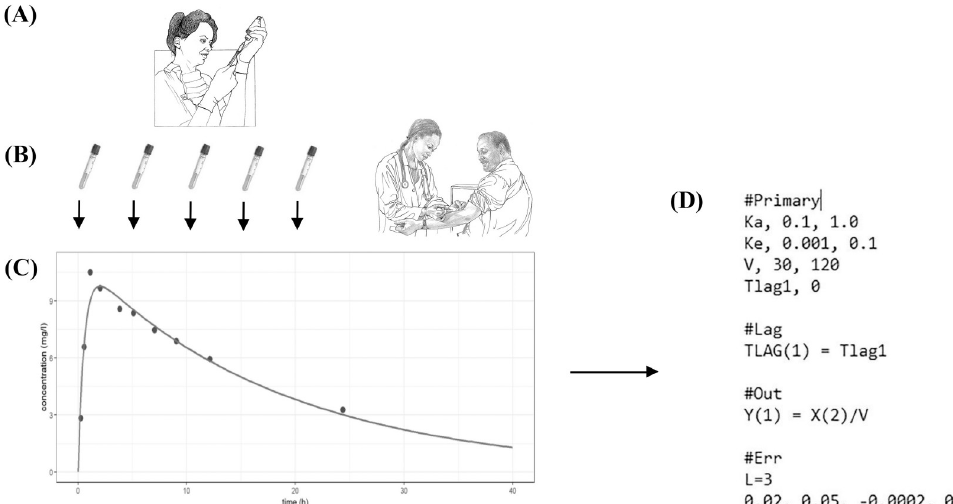
Fig 1. An overview of how therapeutic drug monitoring (TDM) results can be integrated into clinical population and individual pharmacokinetic models on which individualized drug therapy is based. After the drug is administered (A), blood is drawn at specific times (B) and submitted for analysis to obtain time-concentration data with the aim of determining the subject’s individual pharmacokinetic parameters. This can be done using, for instance, either parametric or nonparametric Bayesian analysis (C). An illustrative input pharmacokinetic model file of Pmetrics ™ , a nonparametric population modeling software suite [12], is shown (D). The coefficients of the assay error equation are included in the computer script under “#Err”. Ka, Ke, V and Tlag are notations for pharmacokinetic parameters. Line art images are uncopyrighted and were made available by the National Institute of Diabetes and Digestive and Kidney Diseases, National Institutes of Health, United States at https://www.niddk.nih.gov/news/media-library.